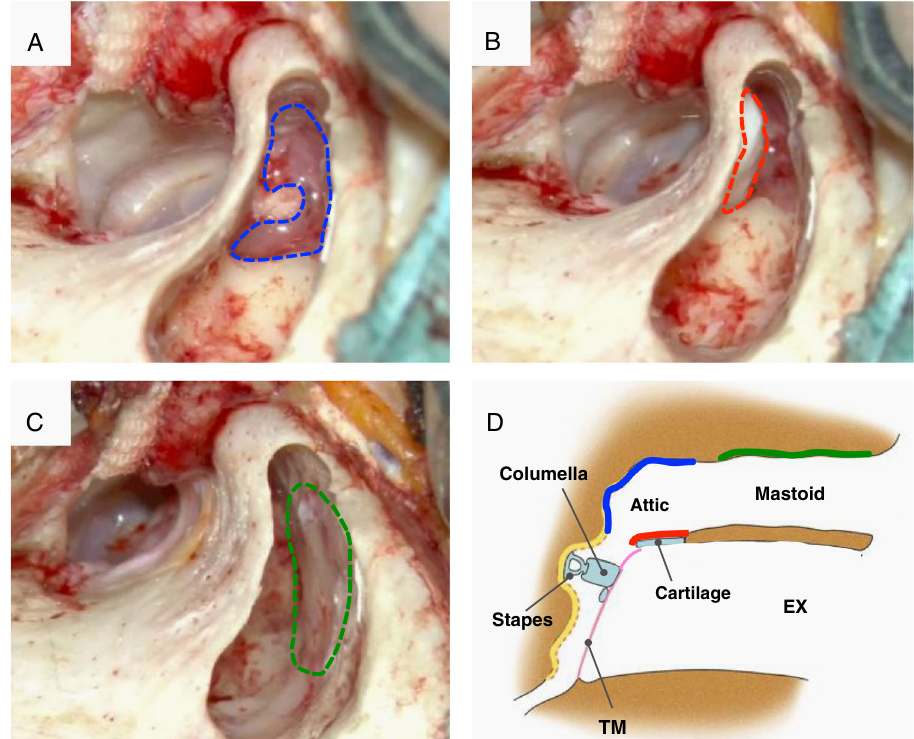
Fig. 5 The procedure for cell sheet transplantation following canal wall up tympanoplasty in a patient with left pars fl accida cholesteatoma. a A cell sheet that was transplanted into the narrow attic. (The transplanted cell sheet is outlined with blue dashes .). b Scutumplasty was carried out together with cell sheet transplantation (hybrid scutumplasty). A cell sheet that was transplanted onto the mastoid cavity surface on a piece of cartilage used in the scutumplasty. (The transplanted cell sheet is outlined in red dashes .). c A cell sheet transplanted onto the exposed bone surface of the middle cranial fossa. (The transplanted cell sheet is outlined in green dashes .). d Diagram of the coronal cross- section. The cell sheet transplanted to the attic is depicted in blue , the hybrid cell sheet-cartilage implant transplanted to the mastoid surface is depicted in red , and the cell sheet transplanted to the bone surface of the middle cranial fossa is depicted in green . TM: tympanic membrane, EX: external ear